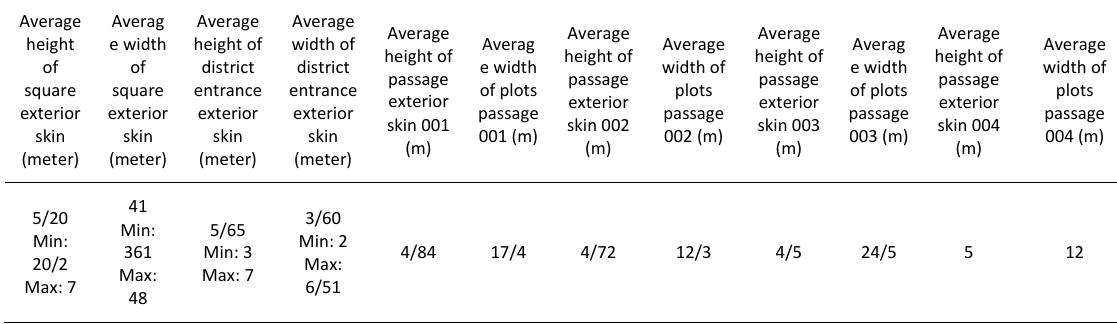
Table 3: Summary of the proportions of Waqht al‐Saat exterior skin district of Yazd